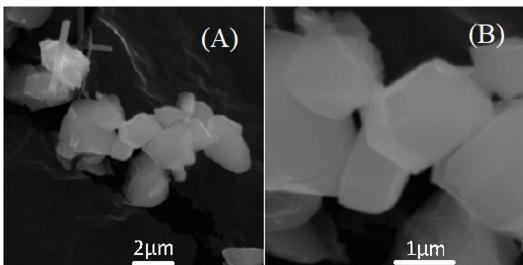
powder:(A) 15 Kx and 4